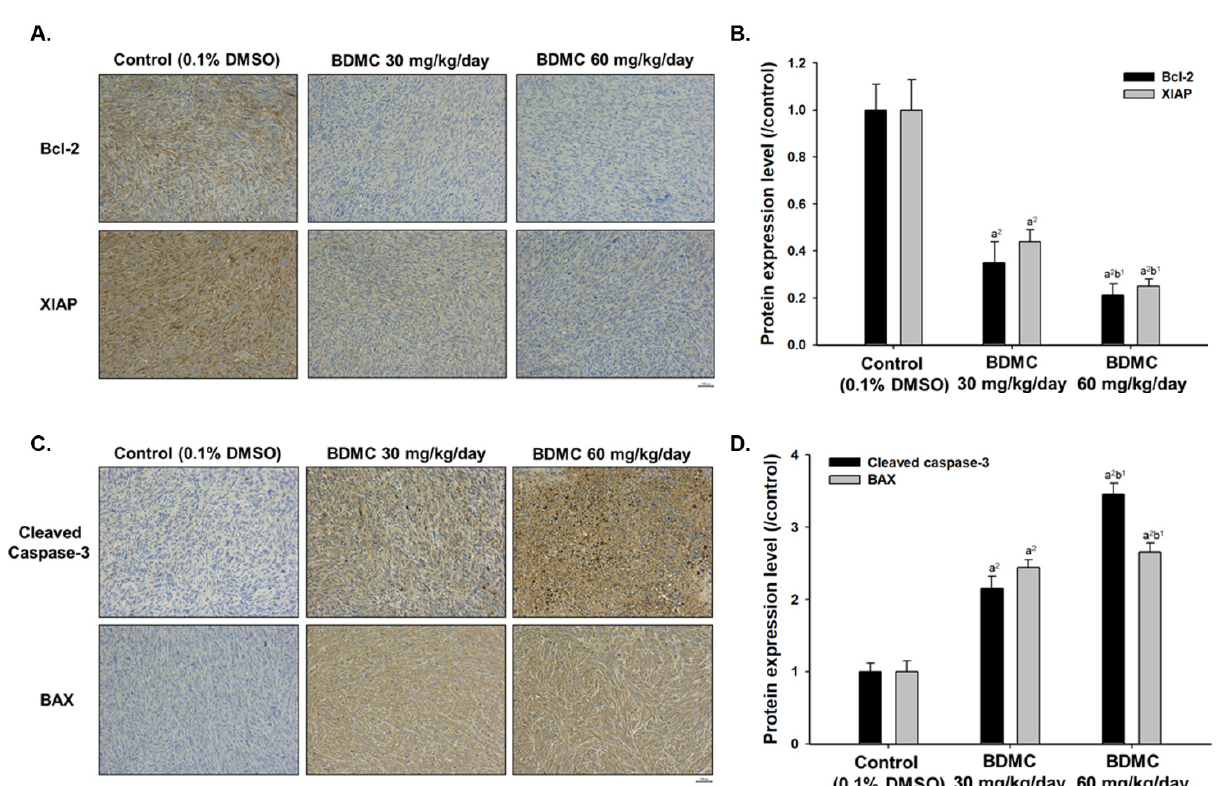
Figure 6. BDMC affects the expression of apoptosis-related proteins in GBM 8401 /luc2 cell xenografts. After treatment, tumors were isolated from GBM 8401 /luc2 xenografts, and IHC staining was performed as described in the Materials and Methods for Bcl-2 apoptosis regulator (Bcl-2) and X- linked inhibitor of apoptosis protein (XIAP) ( A ) and their levels of proteins ( B ); cleaved caspase-3 and Bcl-2-associated X (BAX) ( C ) and their levels of proteins ( D ). a 2 significantly different at p < 0.01 vs. the control group. b 1 significantly different at p < 0.05 vs. the BDMC 30 mg/kg group . Light brown color means the low expression of proteins and heavier brown colors means higher expression of proteins.